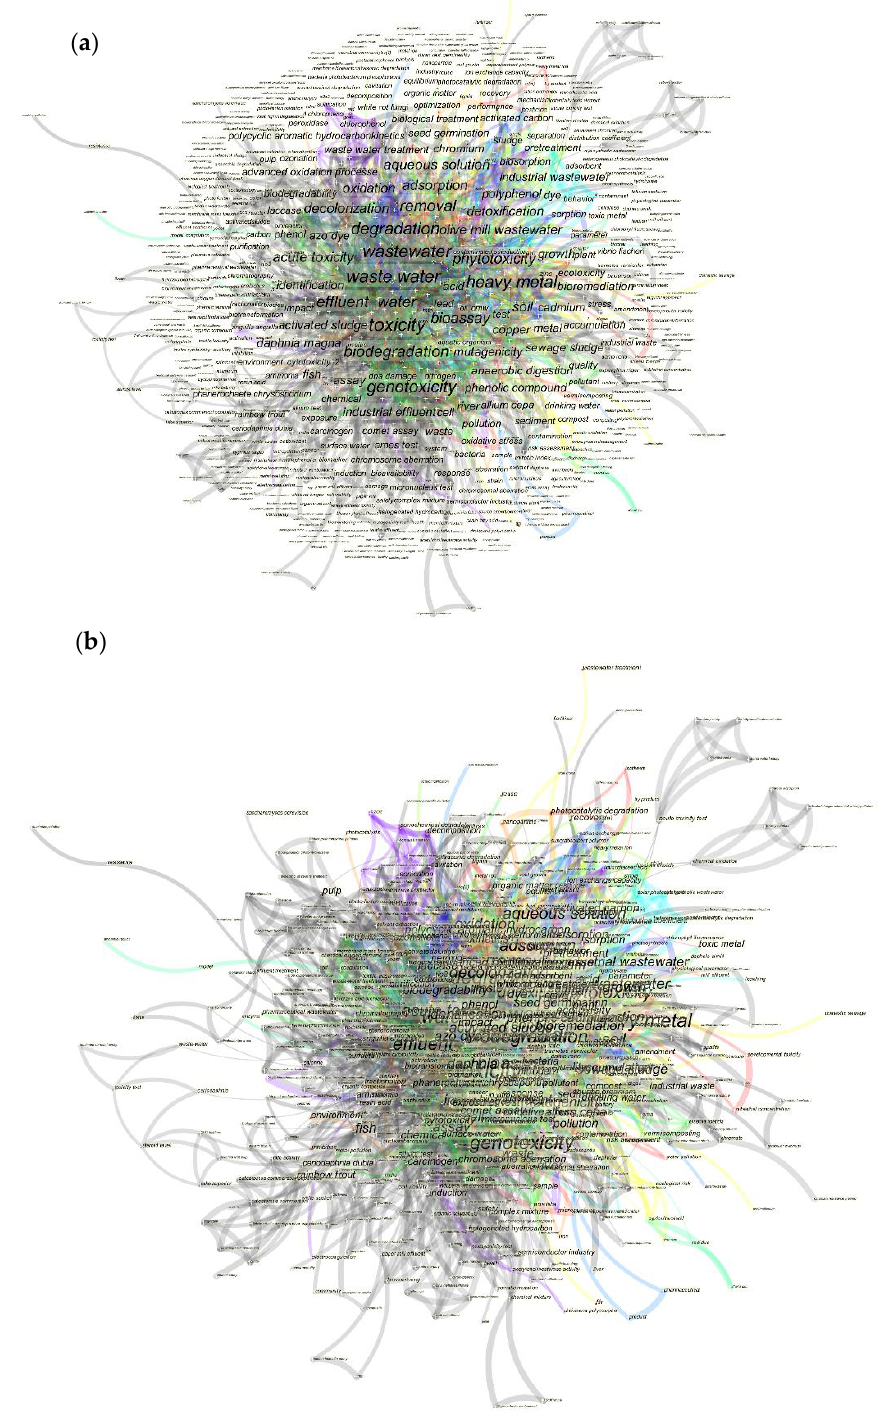
Figure 5. The analysis regarding the appeared keywords in the scientific documents published on the industrial effluent and sludge toxicity analysis from 1950 to 2020 via CiteSpace software. Figure ( a ) represents the keywords’ analysis without the centrality for better visualization, and ( b ) demonstrates the same figure with the respective centrality.